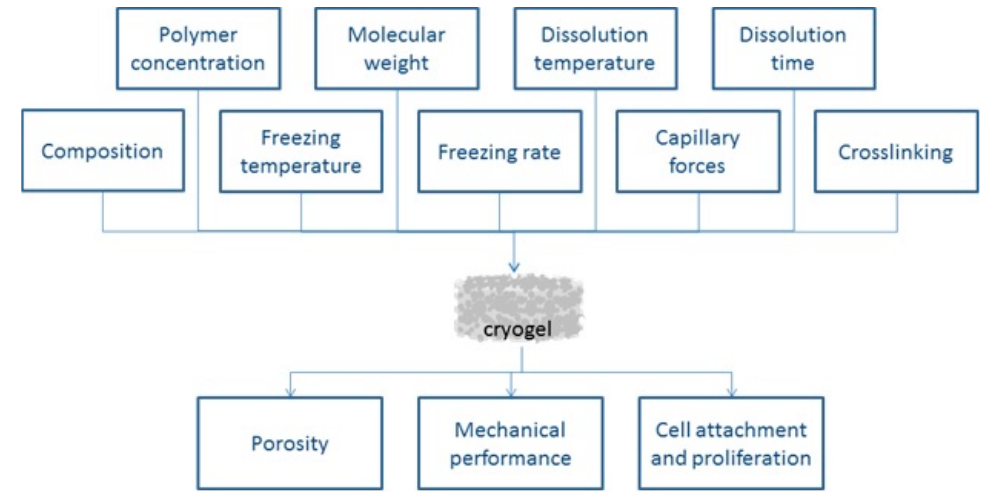
Figure 3. Influence of different factors on cellulose cryogel properties.